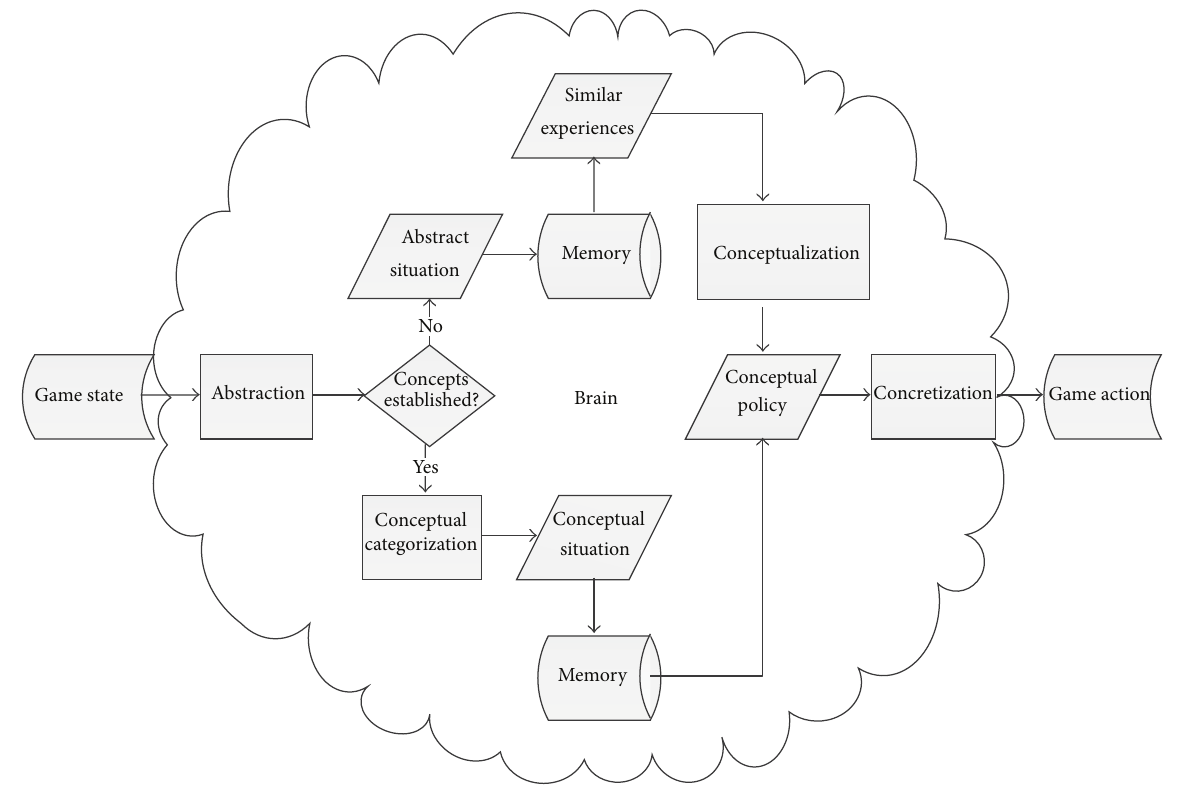
Figure 1: Possible process of human decision making in a video game using conceptual policies, as described above. If memory queries do not yield any results, a concrete policy is computed in real-time using other cognitive faculties such as logic or